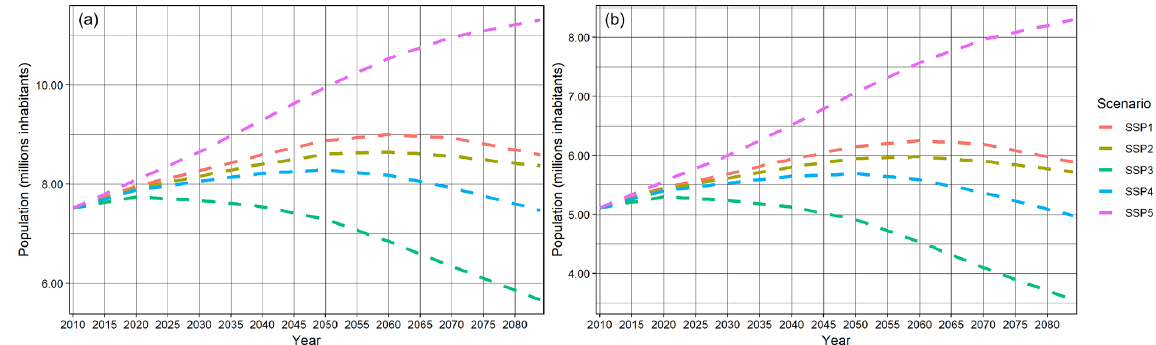
Figure 8. Future population projections for the different SSPs in Catalonia (a) and the Valencian Community (b) .